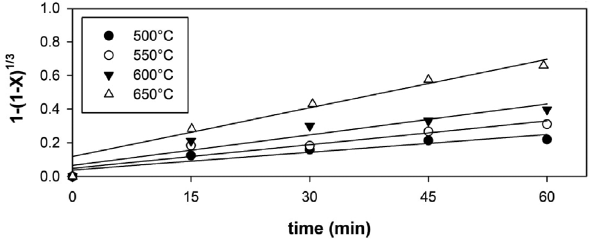
Fig. 9: Plot of 1 − (1 − X) 1/3 with respect to time